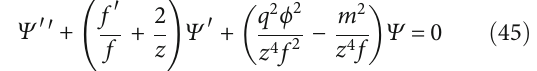
Figure 4: Dependence of the coe ffi cient W ℓ ð z M Þ of the condensate on the matching point z M for an s-wave superconductor ( remarkable that for larger ~ m 2 (thus increased Δ ℓ ), the choice of the matching point becomes irrelevant, provided it is far enough from the pole at z = 0 . Note that the BF-bound for ℓ = 0 is situated at ~ m 2 = − 2 : 25